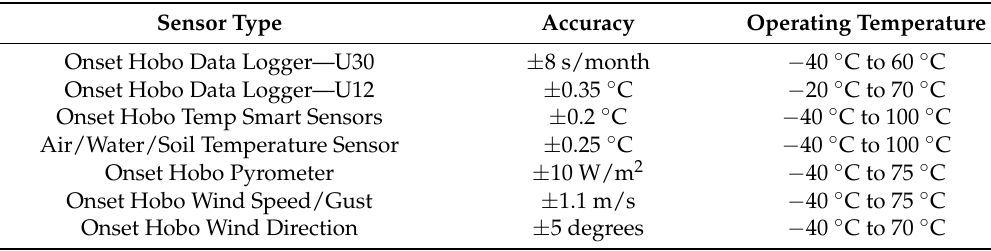
Table 3. Data acquisition technical